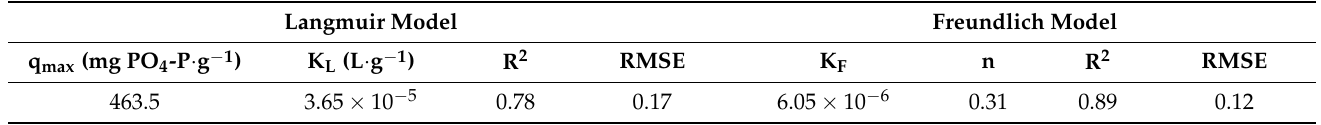
Table 4. Langmuir and Freundlich isotherms parameters for the PO 4 adsorption using Mg-biochar. Langmuir